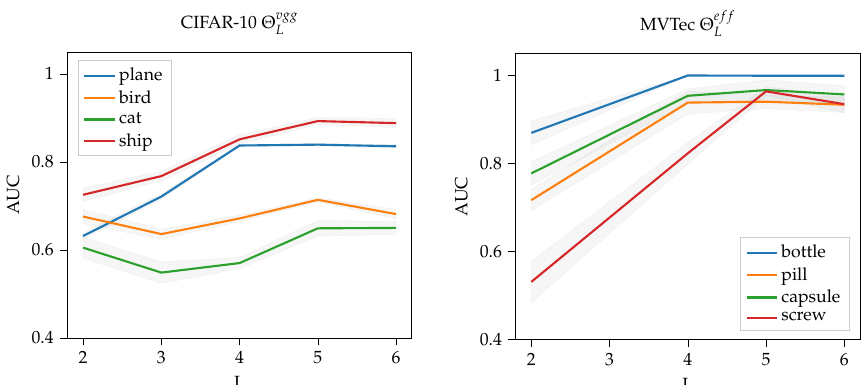
Figure 5. Impact of the chosen feature block index L of neural network on the novelty detection performance. We selected four sensitive classes from the MVTec dataset [7] and the CIFAR-10 dataset [32] for evaluation. On average, a deeper block improves detection performance. The best results were obtained for L = 5.